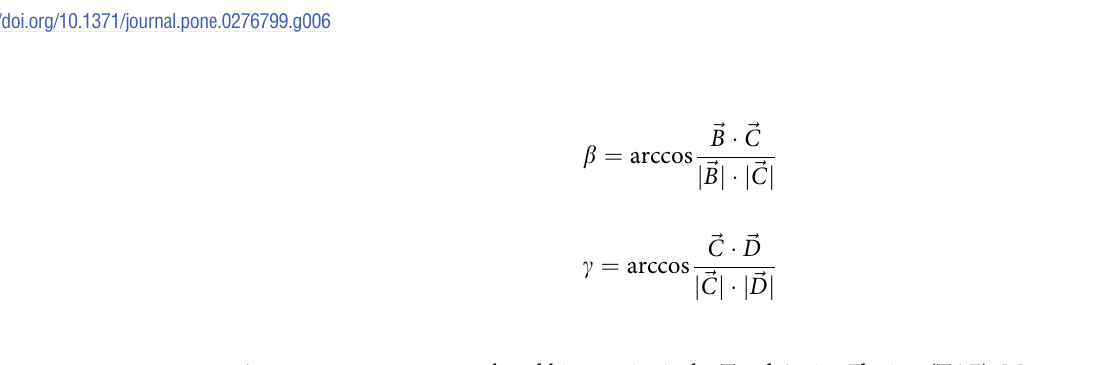
PLOS ONE | https://doi.org/10.1371/journal.pone.0276799 November3,